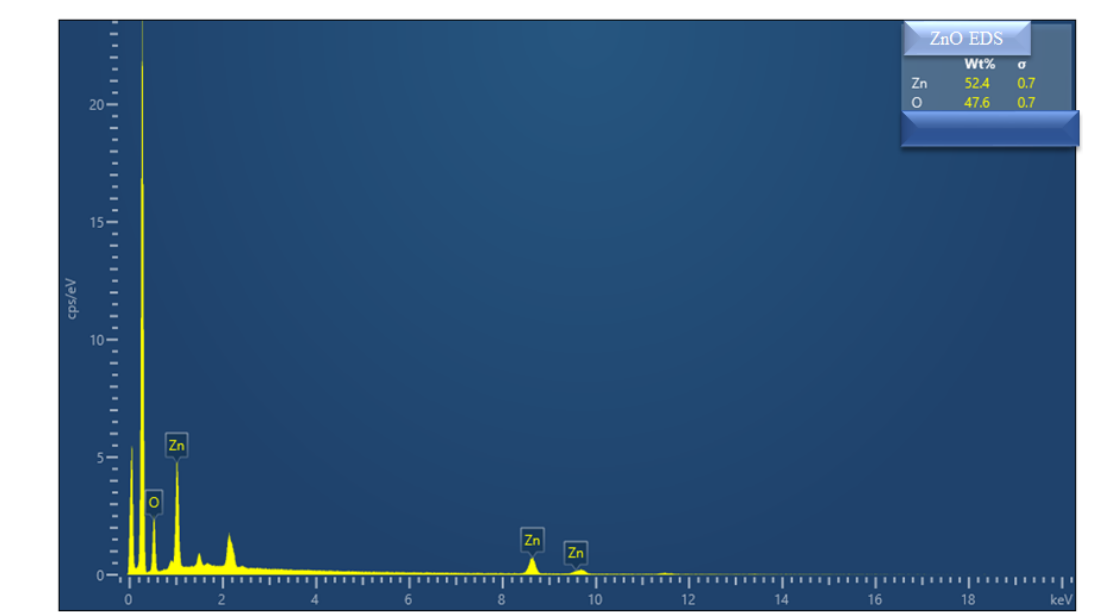
Figure 3. Energy-dispersive spectroscopy (EDS) spectrum of as-prepared ZnO nanoparticles.